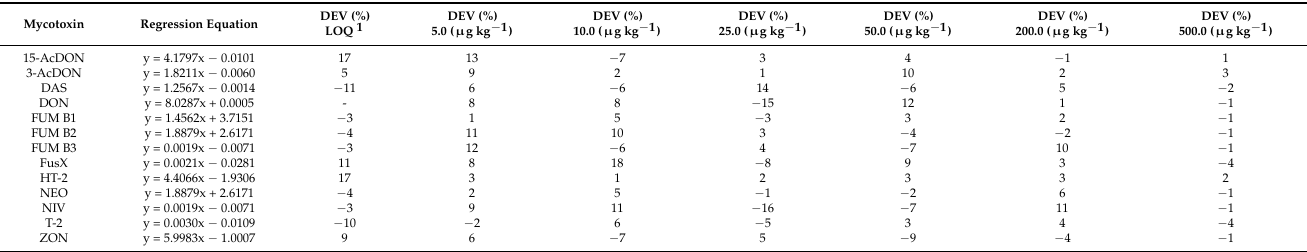
Table A3. Regression equations and deviation of the back-calculated concentration (DEV) of myco- toxins in